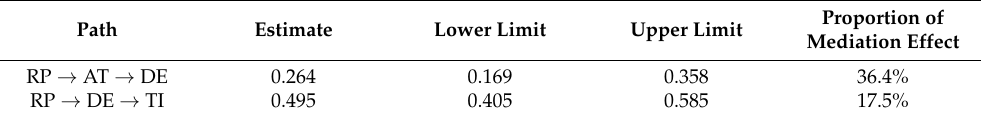
Table 5. Path analysis.